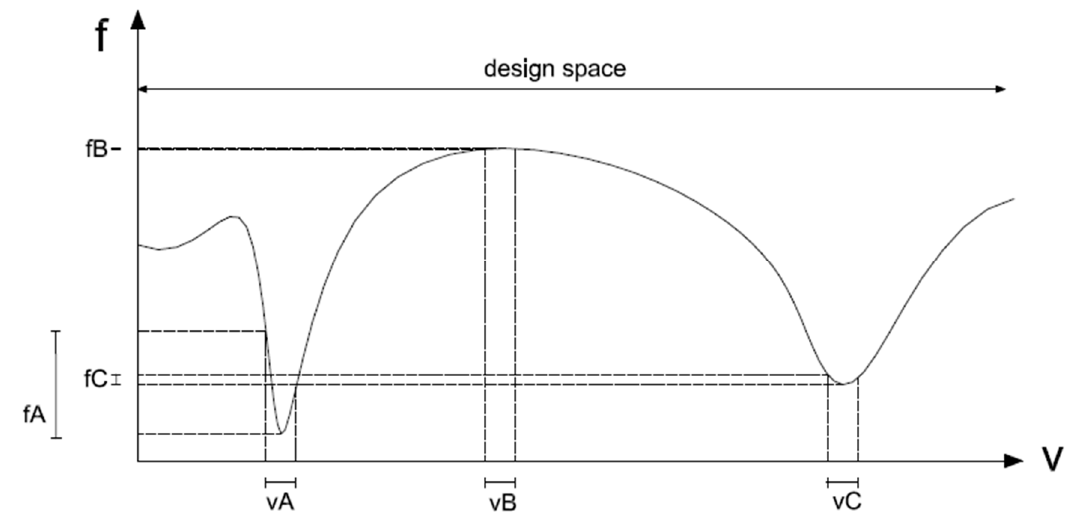
Figure 1. Robust design optimization.